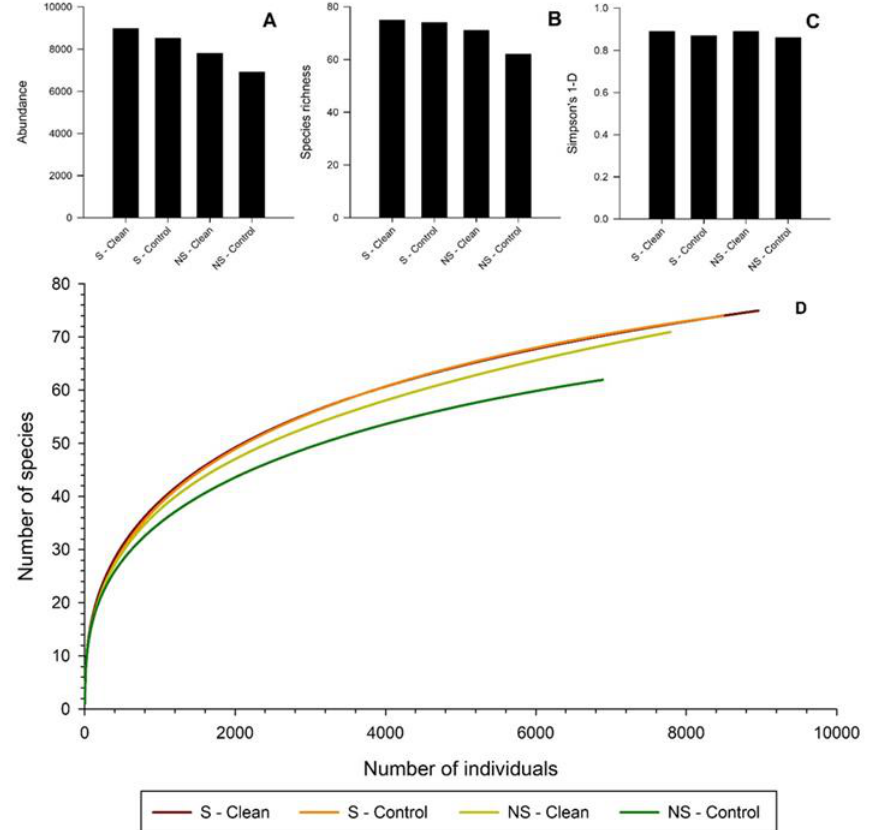
Figure 3. Abundance and diversity metrics for beetles captured in clean vs. control multiple-funnel traps with (S) and without surfactant (NS) treatment during Experiment 1 in southeastern New Hampshire. ( A ) Abundance of bark and woodboring beetles; ( B ) Species richness; ( C ) Simpson’s 1-D estimates; ( D ) Individual-based rarefaction curves.